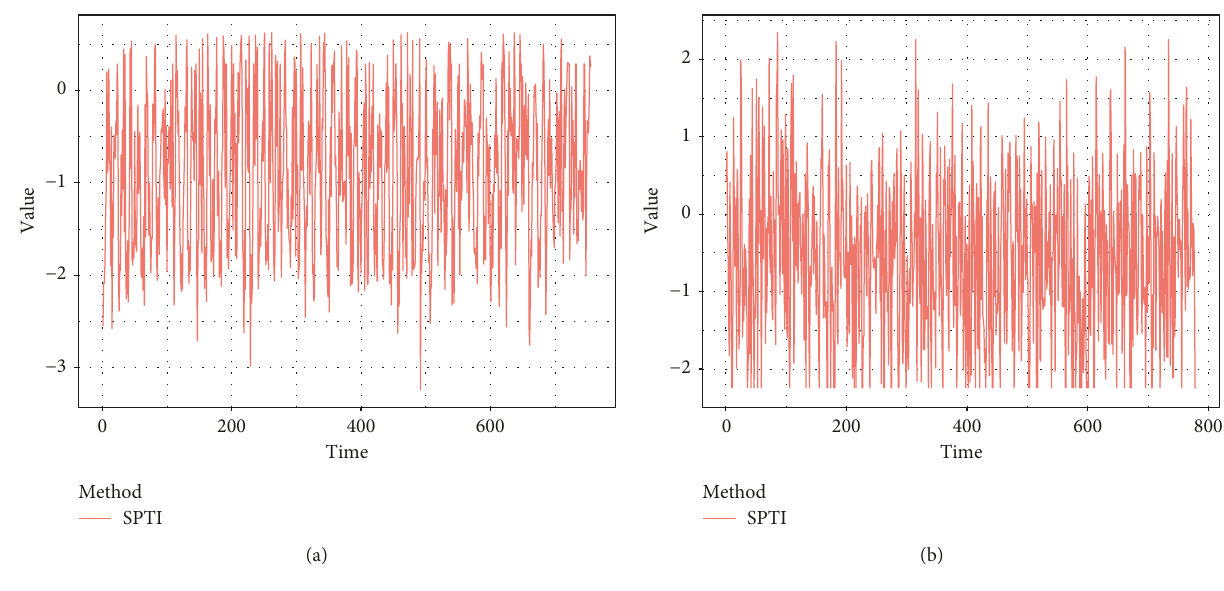
Figure 3: Temporal behavior of SPTI. (a) Astor. (b)